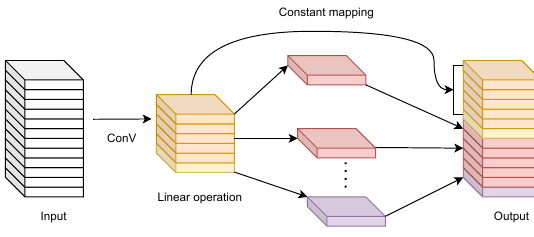
Figure 5. The Ghost